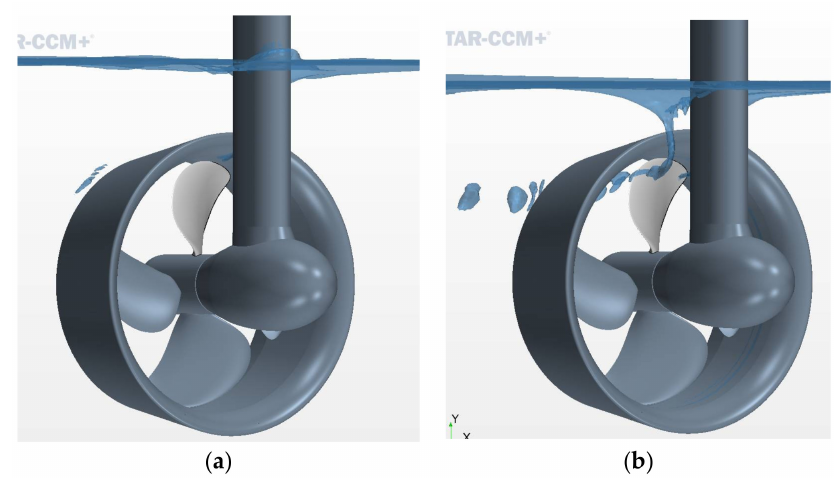
Figure 25. Ventilation inception vortex at the conditions of heavy propulsor loading: ( a ) H/Dp = 0.9, at J = 0.2 (trawling); ( b ) H/Dp = 0.8, at J = 0.0